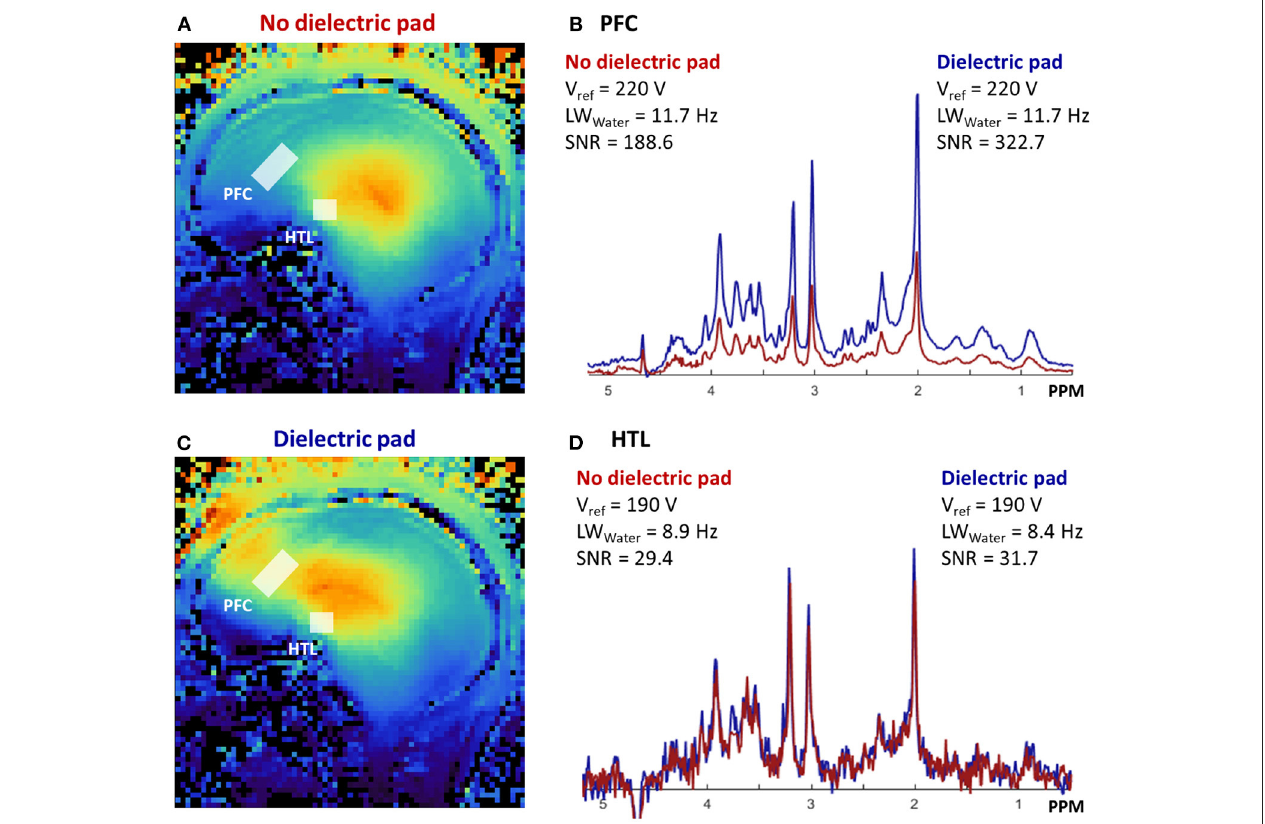
FIGURE 5 | B + 1 map comparisons (A,C) show improvement of B + 1 in the frontal cortex (PFC) with BaTiO 3 pad placed on the subject’s forehead. (B) About 60% gain in signal-to-noise ratio (SNR) was achieved in sLASER MR spectra (TE/TR = 5,000/26ms) in PFC (64 transients) with the pad. (D) Smaller SNR gain was seen in hypothalamus (HTL) (32 transients), because the B + 1 distribution of the coil (without padding) is the highest in the center of the brain, close to the HTL